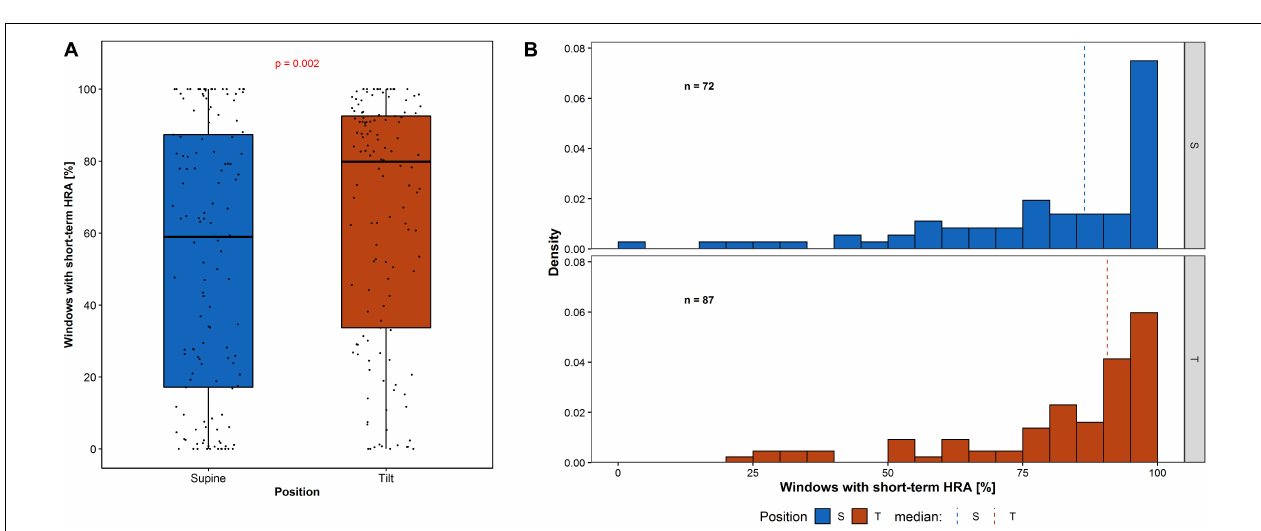
FIGURE 7 | Percentage of short-term HRA occurrence in 150-beat windows: (A) among all participants and (B) the distribution of windows with short-term HRA occurrence among participants with GI > 0.5 in whole 5-min